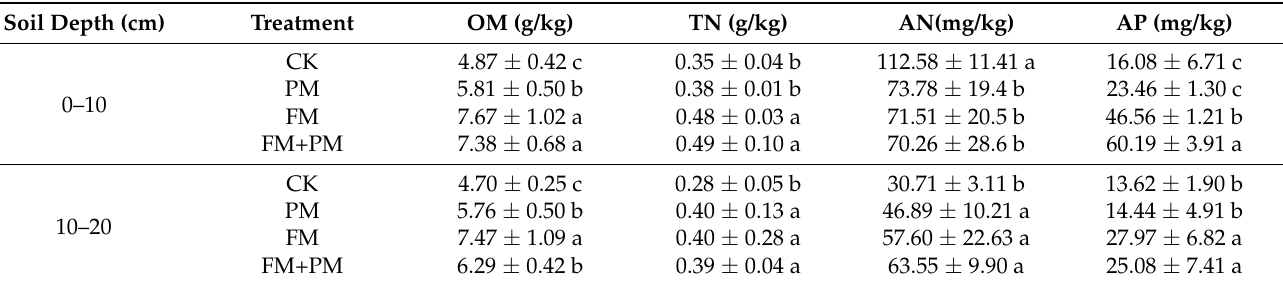
Table 3. Soil nutrients under different treatments.